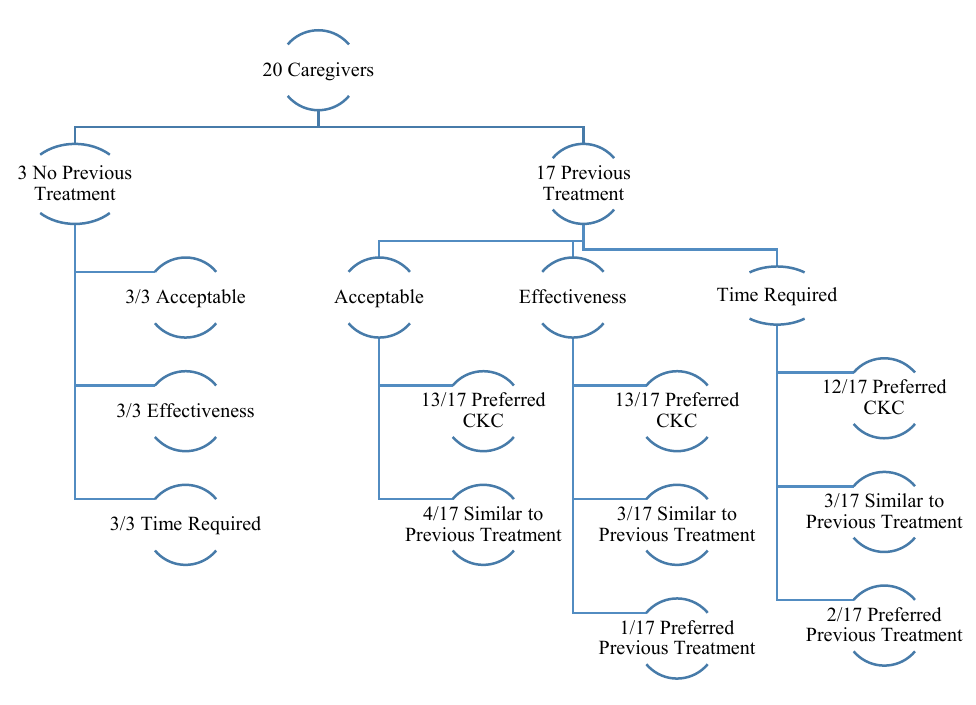
Figure 1. Family interview summary.